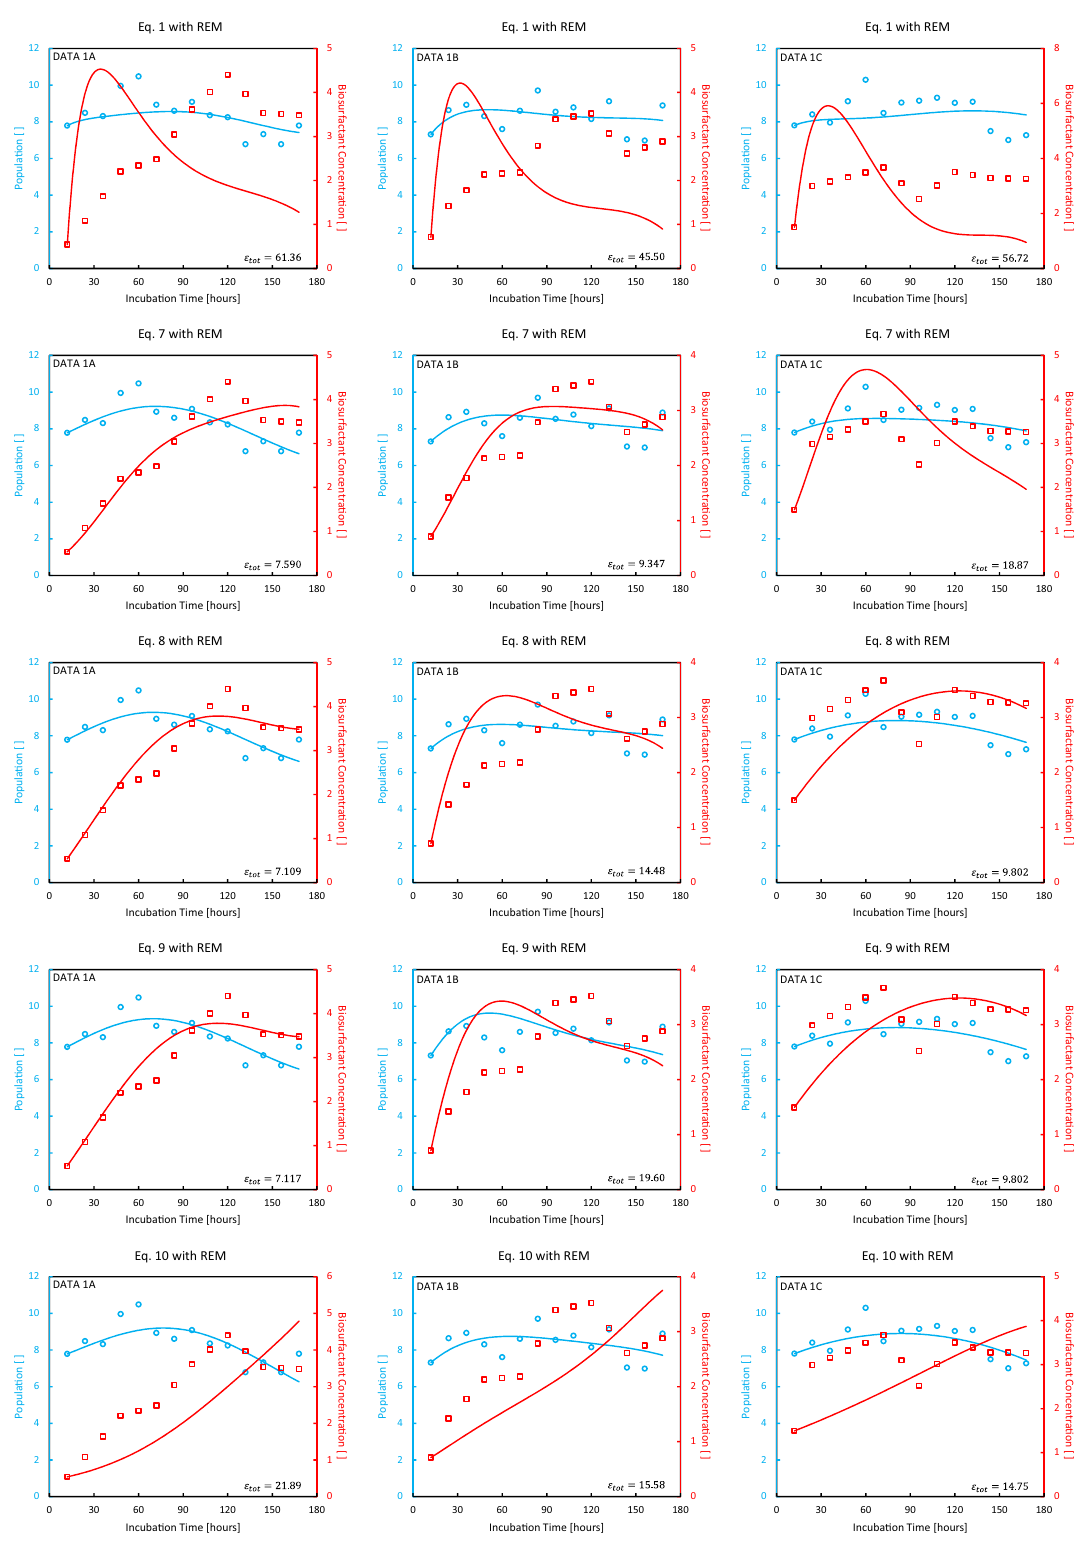
Fig. 5 BBG modelling with REM. The REM refers to Fig. 4. The bacteria growth model (blue line) is overlayed with the experimen- tal data (blue circle) and the biosurfactant concentration (red line) is overlayed with the experimental data (red square). Note that the bac-